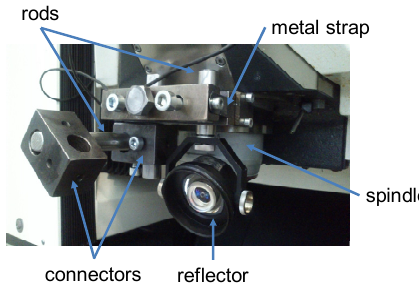
Figure 3. Fixing system of the reflector around the spindle.